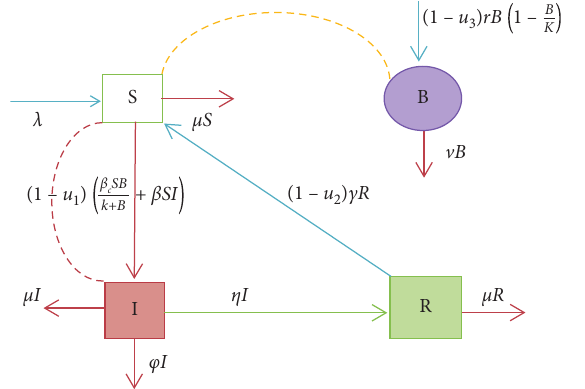
Figure 1: The flow diagram of the SIR-B model of the cholera epidemic with control